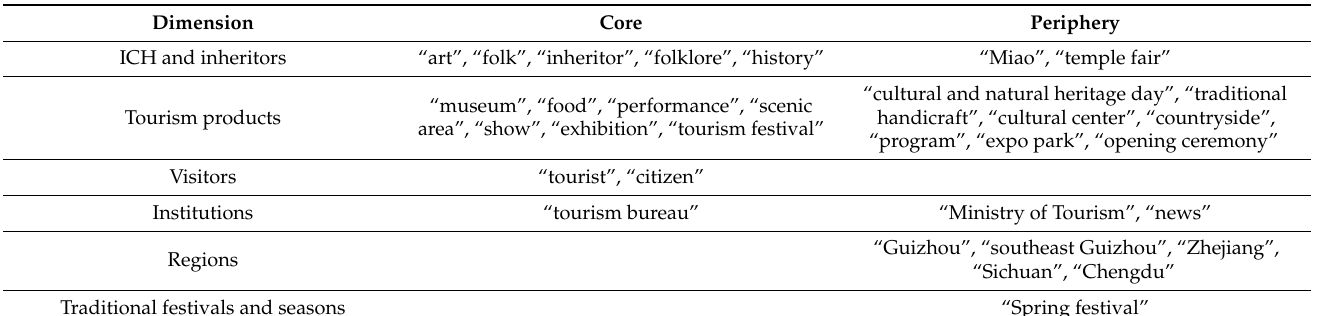
services” dimension did not appear in the semantic network. Table 4. Dimensional distribution of ICH tourism cognition under the core–periphery structure.